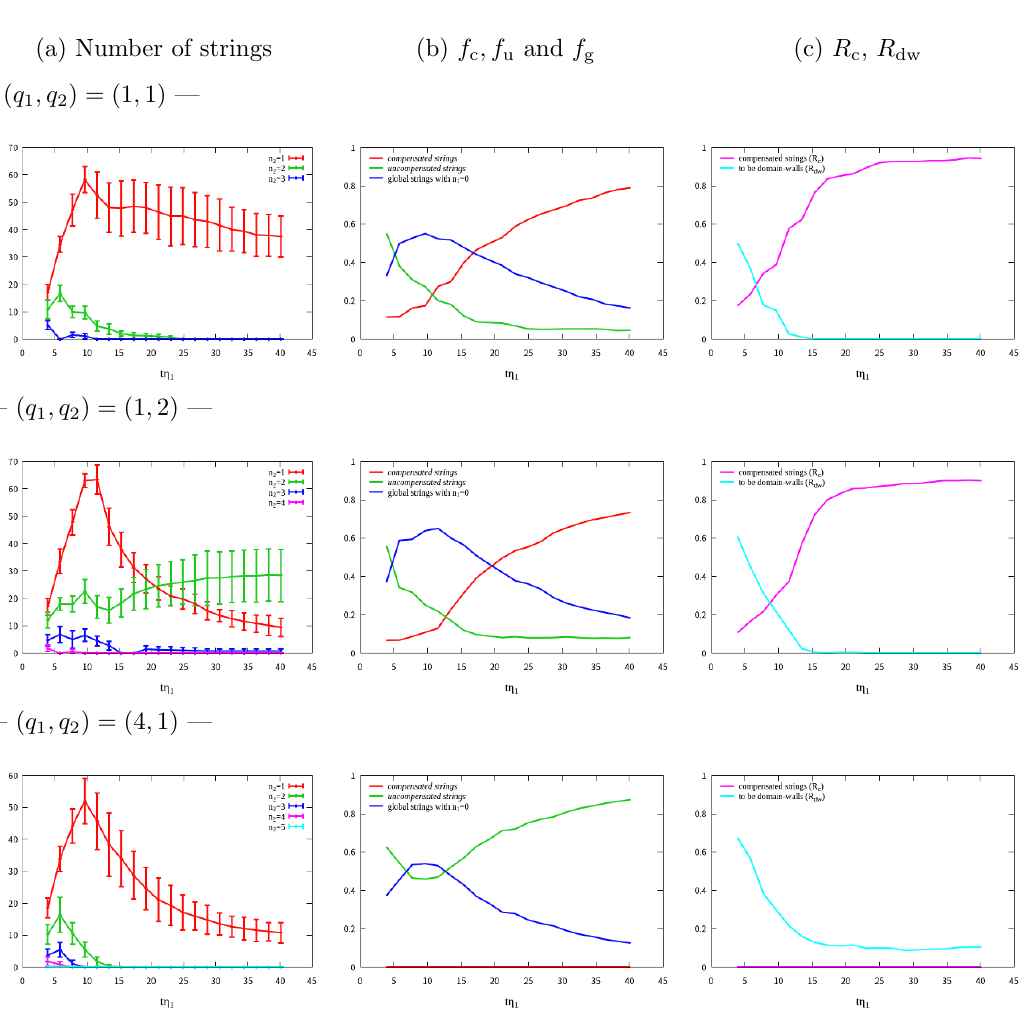
Figure 7. The same (cid:12)gures with (cid:12)gure 5 but for ( q 1 ; q 2 ) = (1 ; 1) ; (1 ; 2) and (4 ; 1).